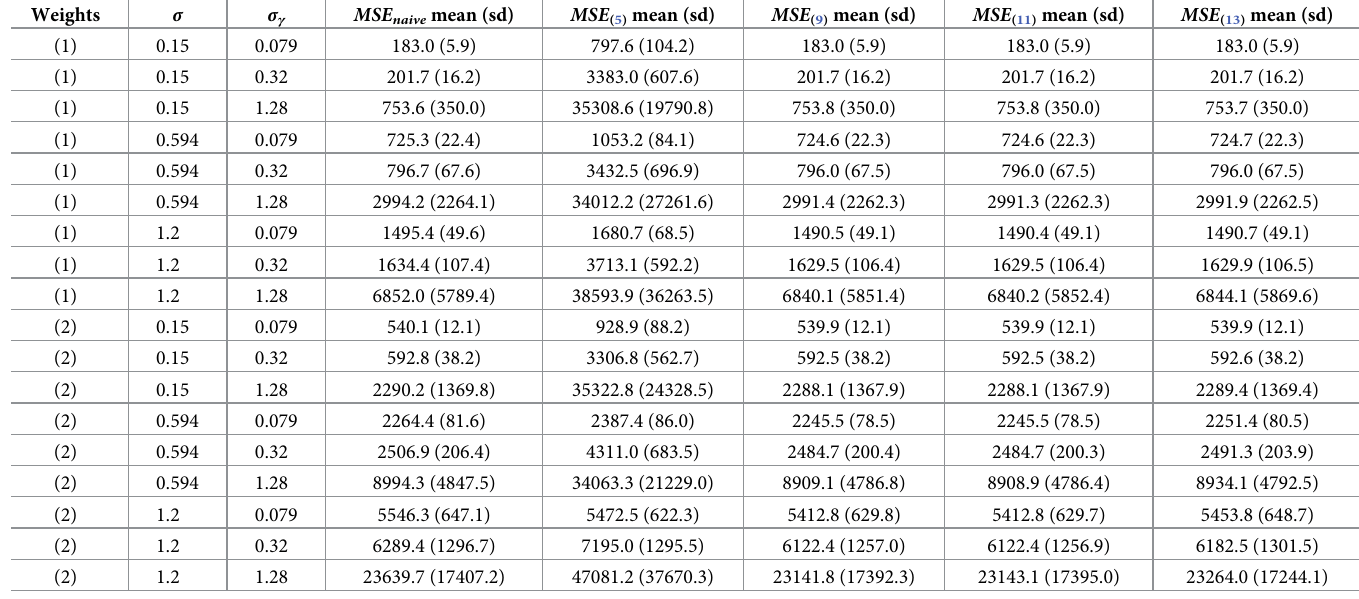
Table 4. Summary of the MSE for the mimic simulation example.